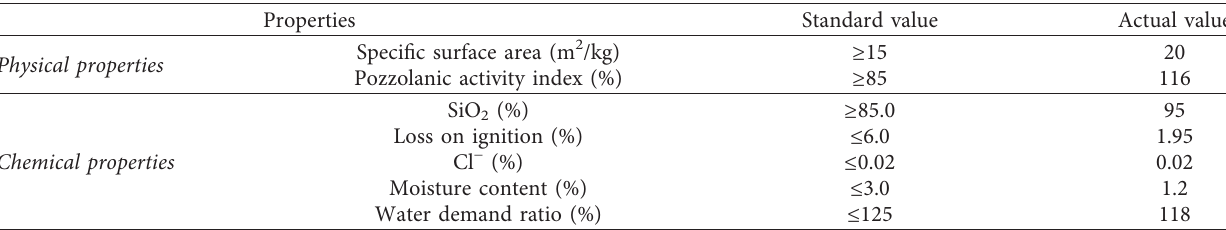
Table 2: Physical and chemical properties of silica fume.